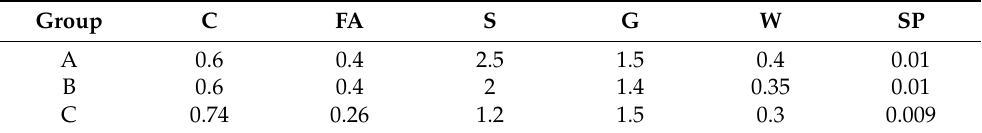
Table 2. Mixture proportions of